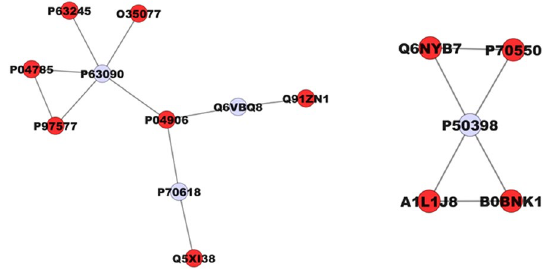
Figure 3. Subnetworks generated by VizMapper for each comparison − 10 ppm F vs. Control Group. Color of node indicates the differential expression of the respective protein, for each comparison. Red nodes indicate protein down-regulation. Gray node indicates proteins presenting interaction but that were not identified in the present study. The access numbers in grey nodes correspond to: Pleiotrophin (P63090), RNA-binding protein PNO1 (Q6VBQ8), Mitogen-activated protein kinase 14 (P70618), and Rab GDP dissociation inhibitor alpha (P50398). The access numbers in red nodes correspond to: Guanine nucleotide-binding protein subunit beta-2-like 1 (P63245), Glycerol-3-phosphate dehydrogenase (O35077), Protein disulfide-isomerase (P04785), Fasciculation and elongation protein zeta-1 (P97577), Glutathione S-transferase P (P04906), Coronin-1A (Q91ZN1), Lymphocyte cytosolic protein 1 (Q5XI38), Ras-related protein Rab-1A (Q6NYB7), Ras-related protein Rab-8B (P70550), Protein Rab5b (A1L1J8), and Protein Rab5c